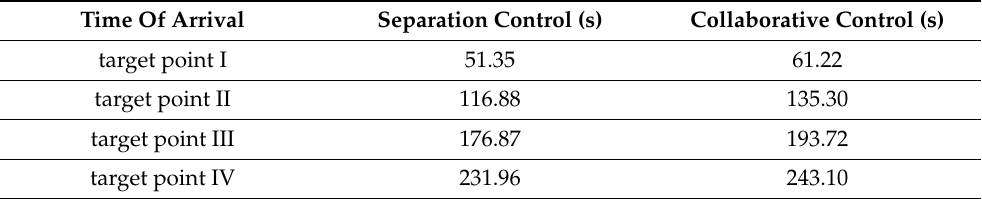
Table 7. Time of arrival at each point of the collaborative control and separation control. Time Of Arrival